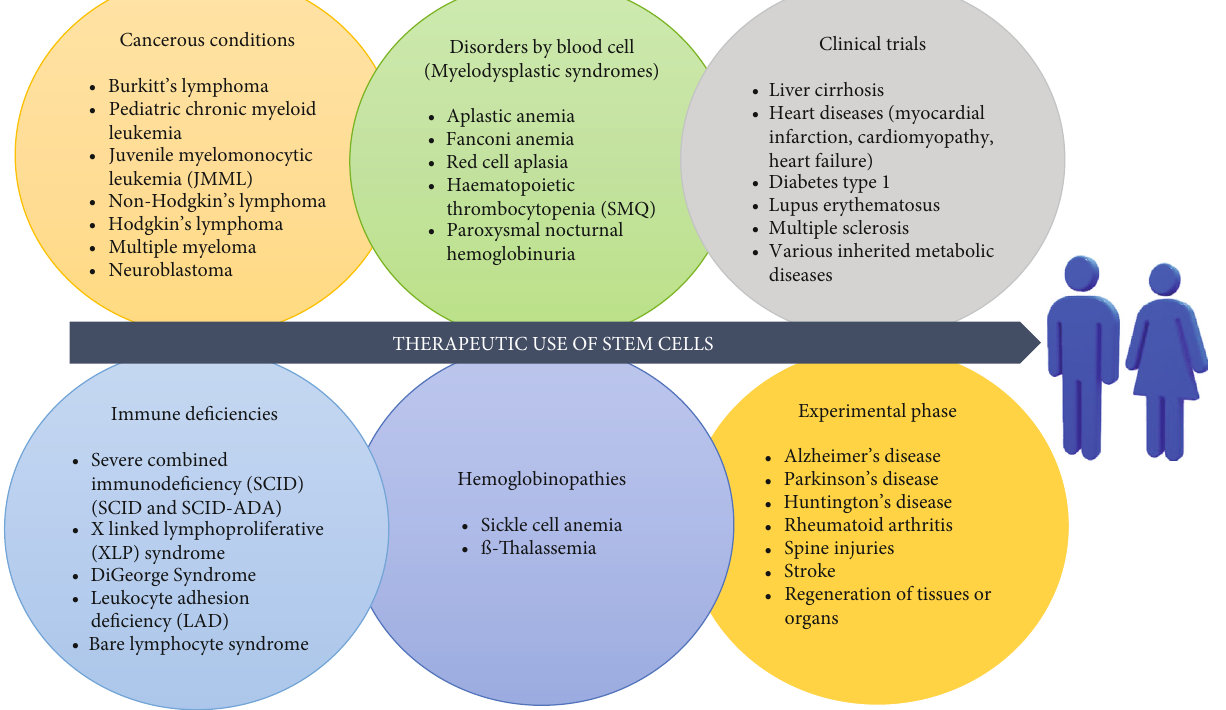
Figure 1: Summary of the diseases treated or even therapies in clinical trials or experimentation with stem